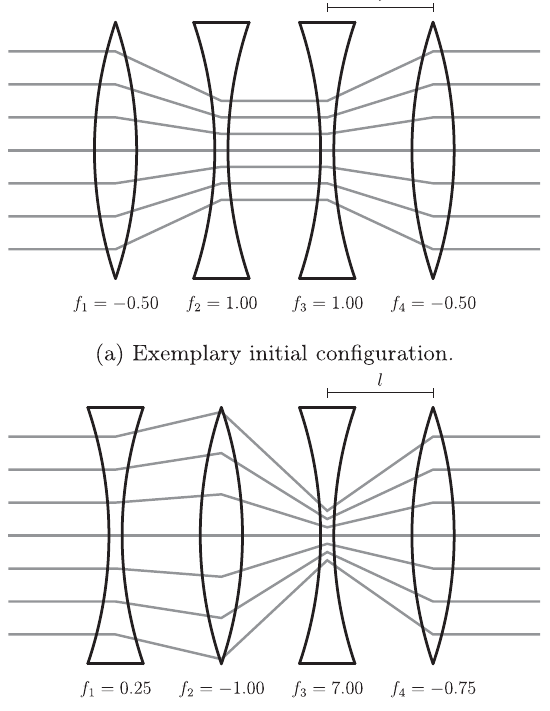
FIG. 2. Schematic representation of the four-lens system in different